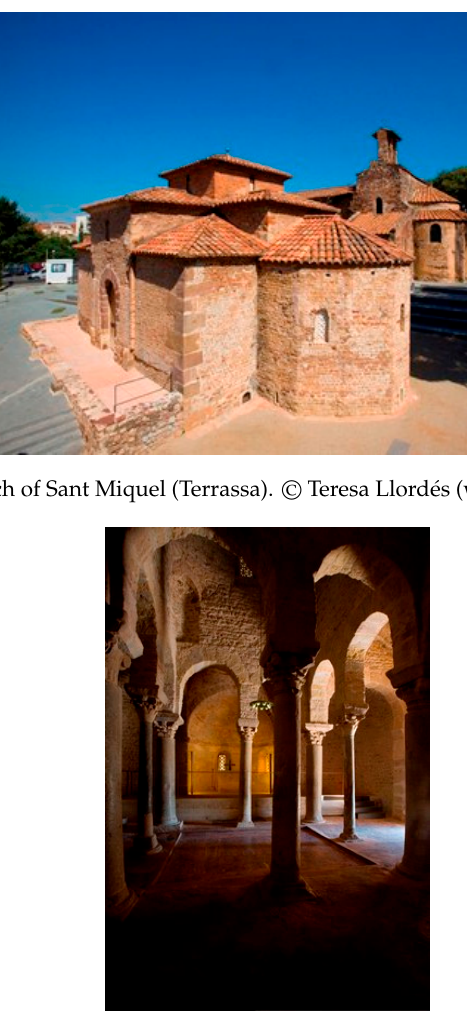
Figure 4. Church of Sant Miquel (Terrassa). © Teresa Llordés (with kind permission).